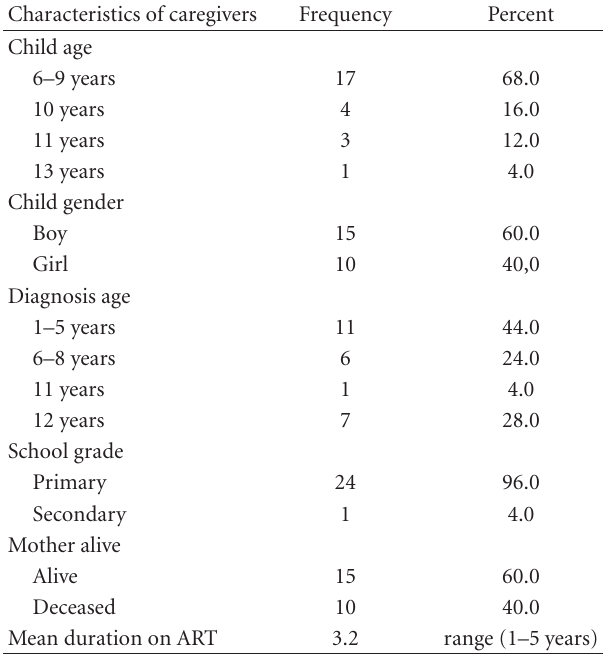
Table 2: Demographic characteristics of children ( n = 25).